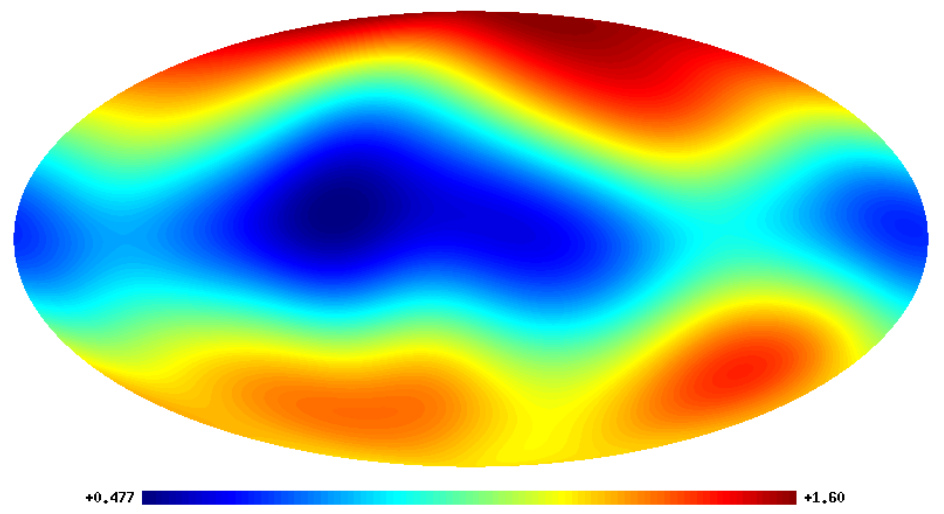
Figure 8. The optimal Gaussian-kernel-smoothed Sky Exposure Function of the current GRB data. A factor of (cid:38) 3 is between the minimum and maximum, and the galactic disk is also visible (cf. Figure 1 and Figure 4 of Balázs et al.